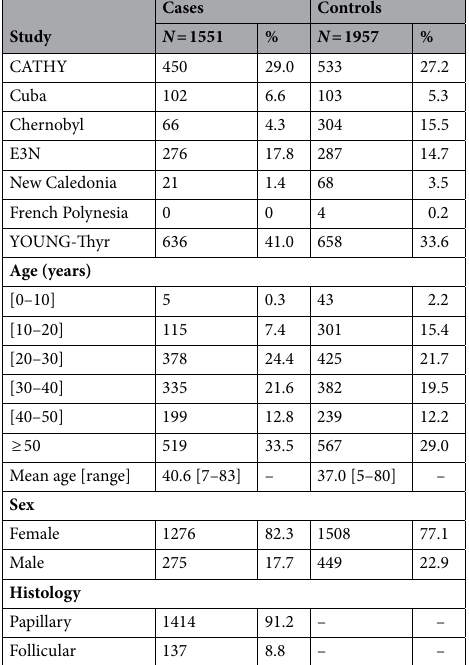
Table 1. Characteristics of participants of the seven EPITHYR case–control studies used in the gene-, pathway- and network-level analyses.